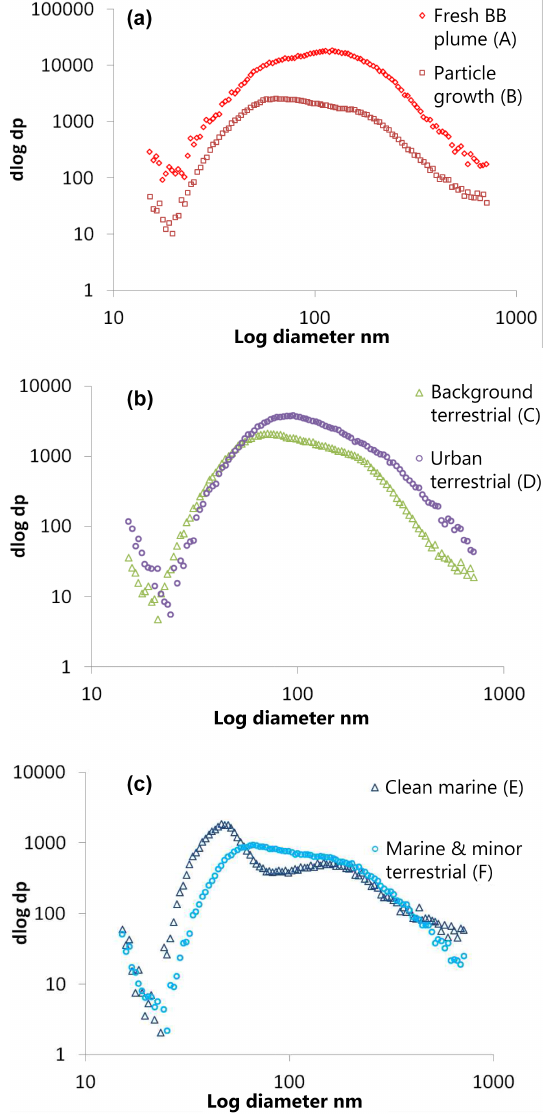
Figure 4. Average particle size distributions (with log scale on both axes) from BB1 corresponding to periods shown in Fig. 3 including (a) the fresh plume (Period A) and particle growth (Pe- riod B) (b) background terrestrial (Period C) and urban terrestrial (Period D) and (c) clean marine (Period E) and marine and minor terrestrial (Period